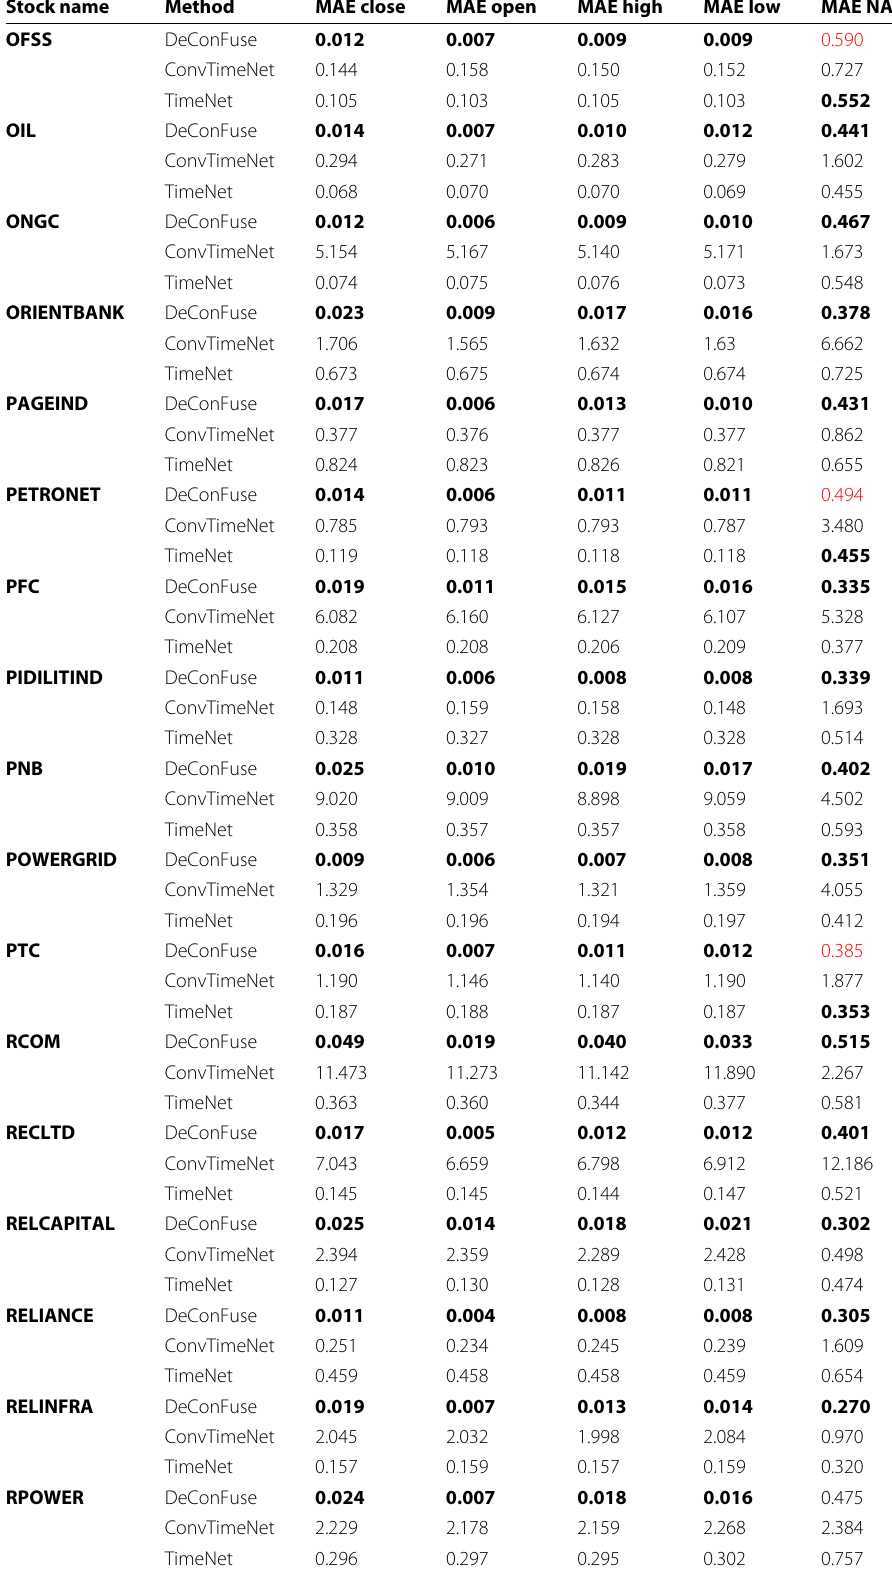
Table 5 Stock-wise forecasting results ( Continued